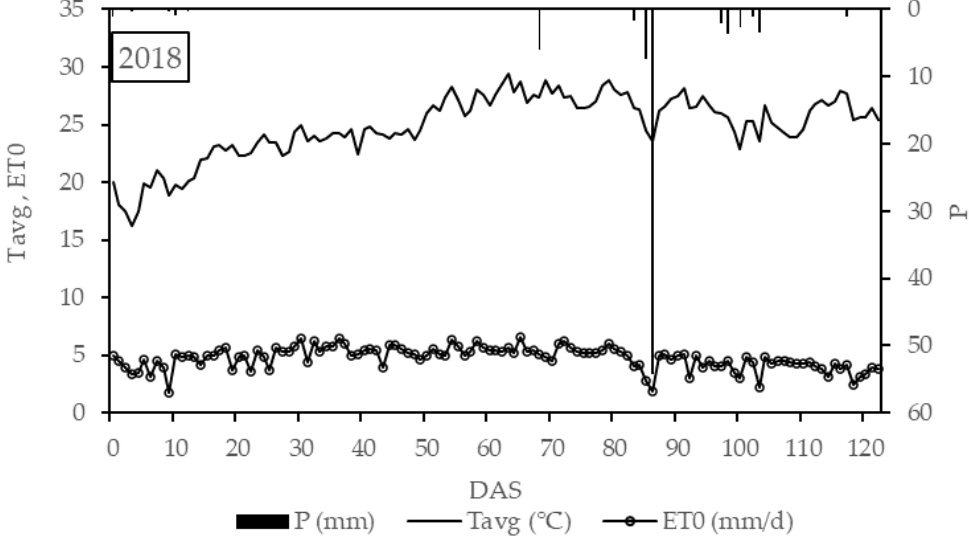
Figure 2. Trends of daily average temperature (T avg ), reference evapotranspiration (ET0), and precipitation (P) during the study period.